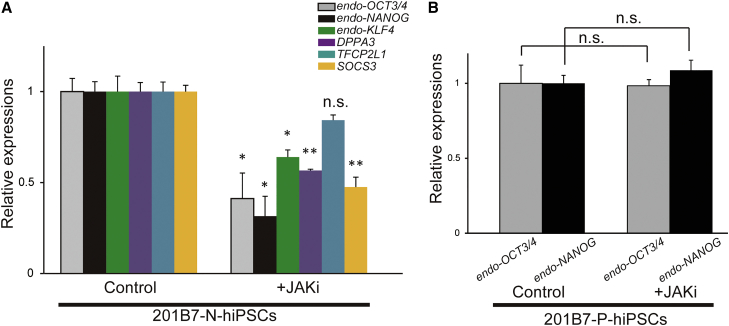
Jak/Stat3 Signal ResponsivityqPCR analysis of the 201B7 N-hiPSCs (A) and P-hiPSCs (B) with and without a Jak inhibitor (Jaki) for the endogenous expressions of Jak/Stat3 signaling-related genes and pluripotency-related genes (n = 3, mean ± SEM; independent experiments; ∗p < 0.05; ∗∗p < 0.01; n.s., not significant; t test).